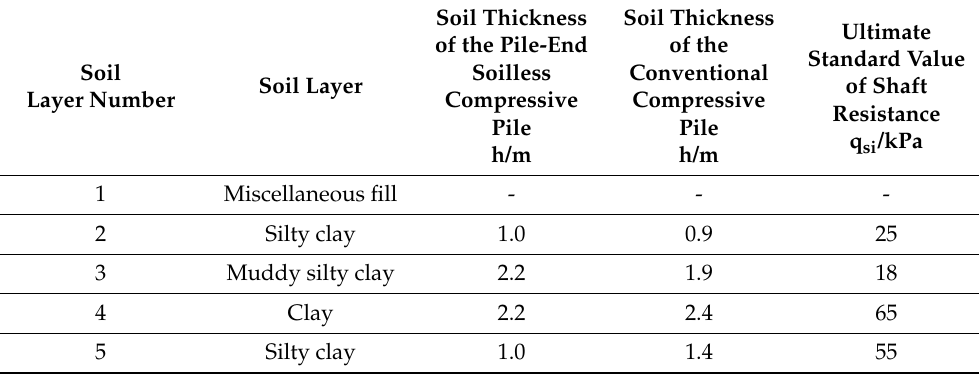
Table 1. Parameters of each soil layer at the test